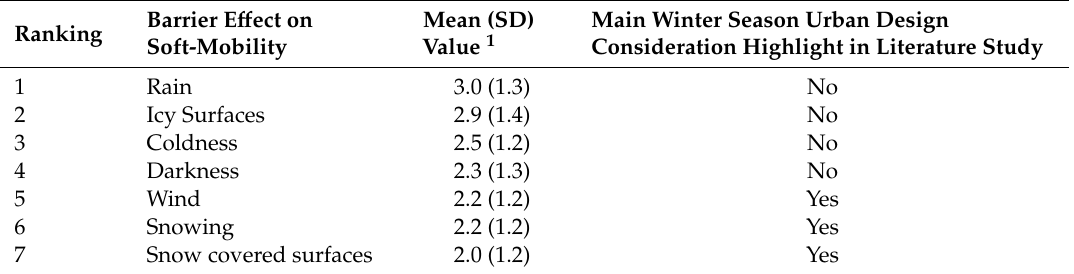
Table 2. Residents ( n = 212) EAMQ-Climate ranking of the ambient and terrain barriers to soft-mobility in